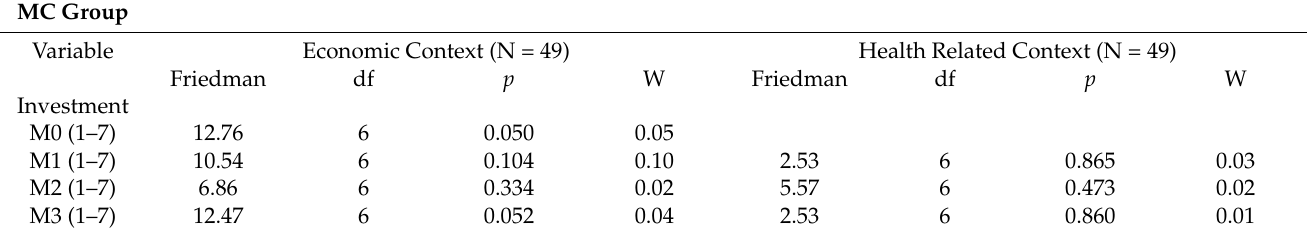
Table 4. Repeated measures comparison of investment during the 7 runs for each type of human medi- ator (M1–M3), to investigate learning of mediator feedback contingencies (Friedman non-parametric test) on economic and health related context experimental tasks for patients with metabolic